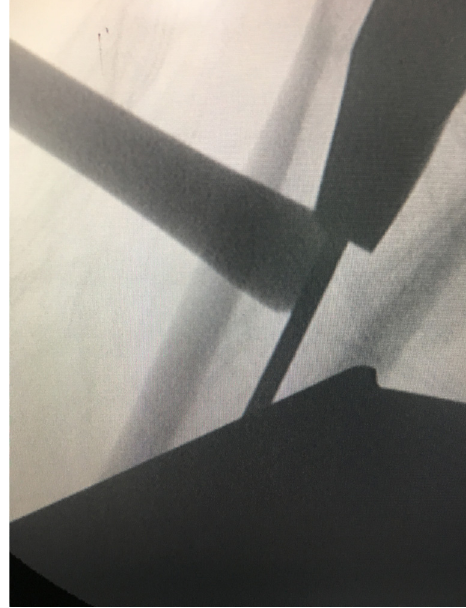
Figure 3. A long strip bony window by using an osteotome, which is just right for inserting a bone detacher. Figure 4. The broken reamer was moved completely, and PFNA was